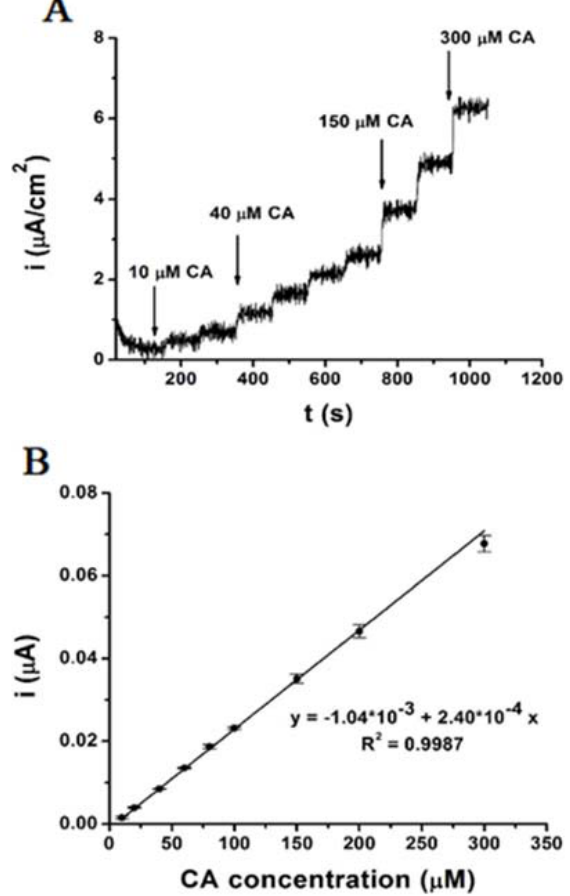
Figure 7. ( A ) Chronoamperogram corresponding to CA additions (10, 20, 40, 60, 80, 100, 150, 200, and 300 µ M) at the PEDOT-Tyr / SNGC biosensor; ( B ) Calibration plot with error bars expressed as standard deviation.